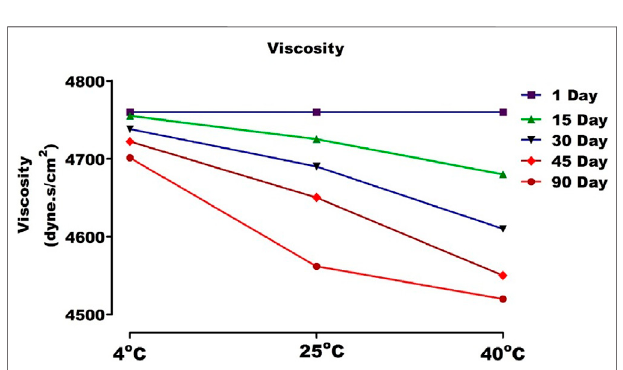
FIGURE 12 | Viscosity of topical gel containing AM extract at different